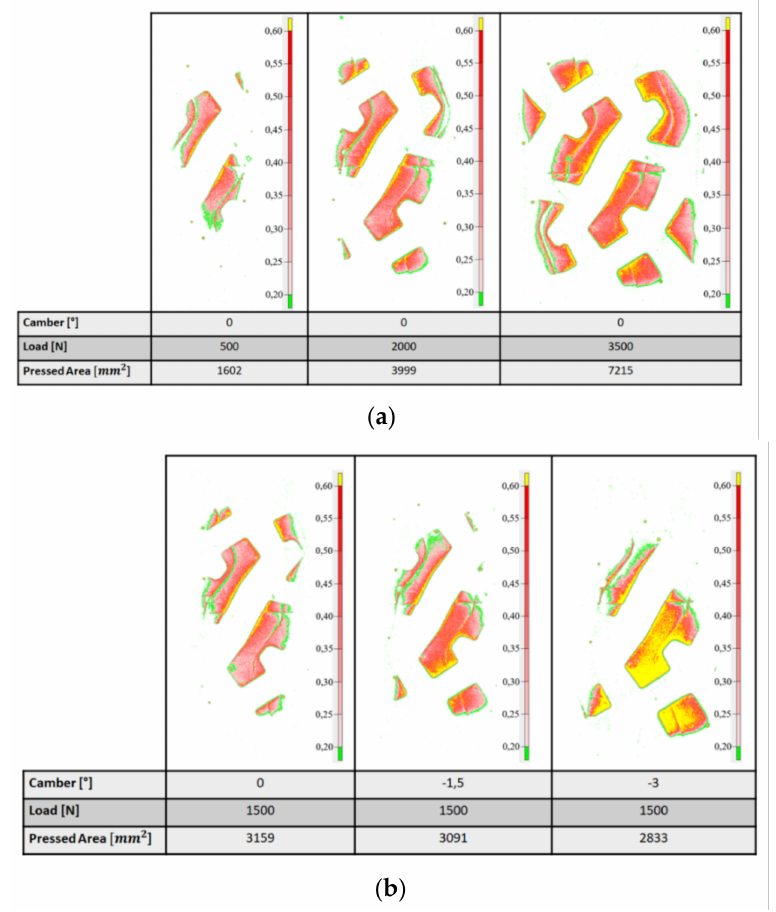
Figure 6. Contact patch analysis: ( a ) Influence of load; ( b ) influence of camber